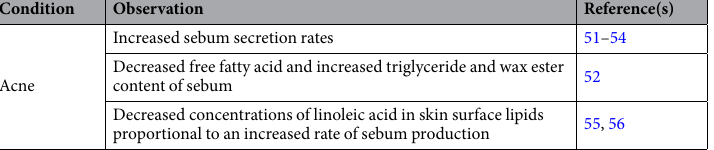
Table 1. Examples of clinical conditions that have been associated with changes in sebum secretion rate or sebum composition. Note that in this context, sebum is used as a generic term for residual skin surface